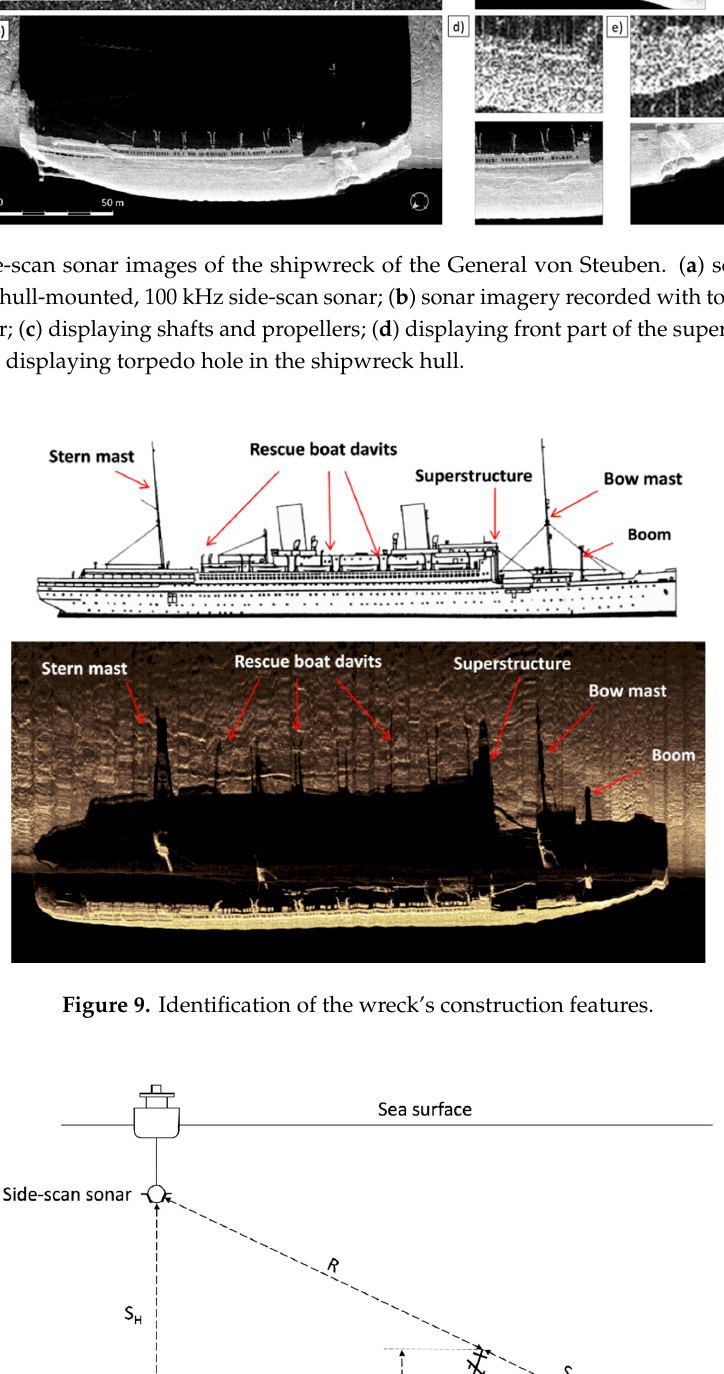
Figure 10. Calculation of object’s height based on similar triangles.